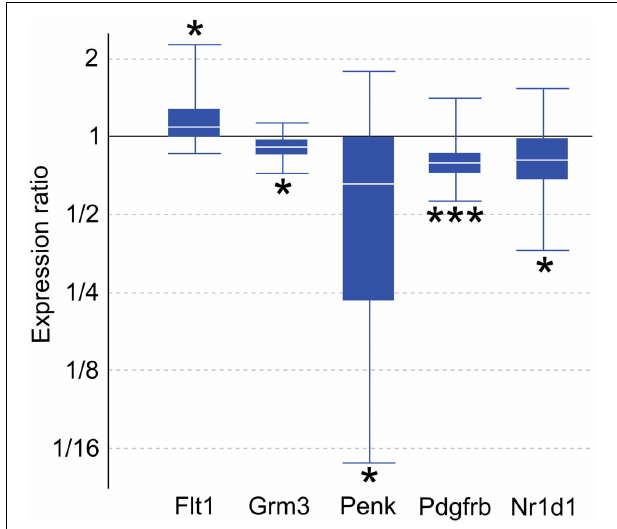
FIGURE 2 | Quantitative real-time PCR confirmation of expression changes for genes of interest in maternal mPFC compared to virgin. Relative expression distribution (Y-axis) represented as a ratio of lactating maternal vs. virgin ( n = 10 per group) normalized against two references genes, Ppia and Ywhaz , and shown by box-and-whisker plots as medians (white lines), interquartile ranges (boxes), and ranges (whiskers). Ratios over one indicate genes that are more highly expressed in lactating maternal mPFC than in virgin. ∗ p < 0 . 05; ∗∗∗ p < 0 .